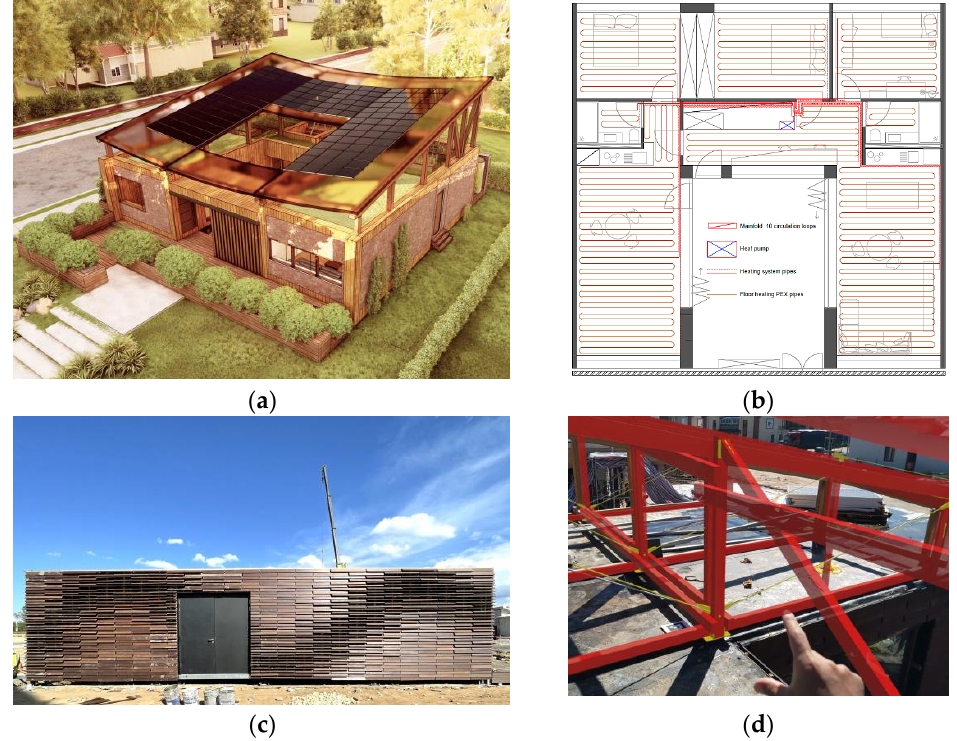
Figure 6. Main results of the Aurora. ( a ) Solar roof. ( b ) Underfloor heating/cooling. ( c ) Bamboo brick wall. ( d ) MR for construction.